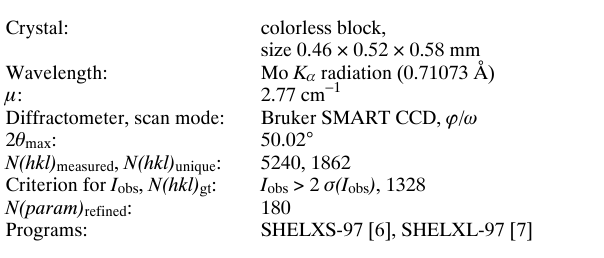
Table 1. D a t a collection a nd h a ndling.